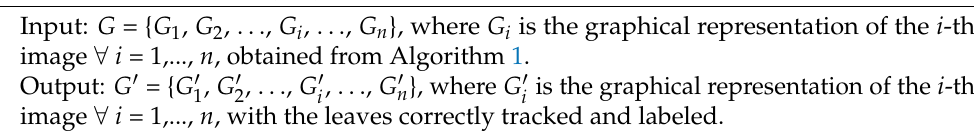
Algorithm 3 Leaf tracking